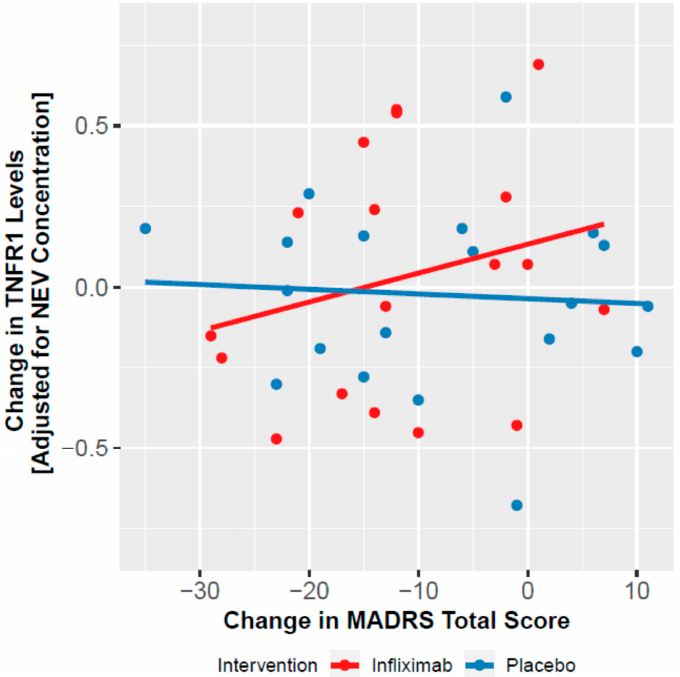
Figure 2. Association between changes in TNFR1 levels, adjusted for Alix concentration, and changes in MADRS scores, in the placebo and infliximab treated groups, at week 6.